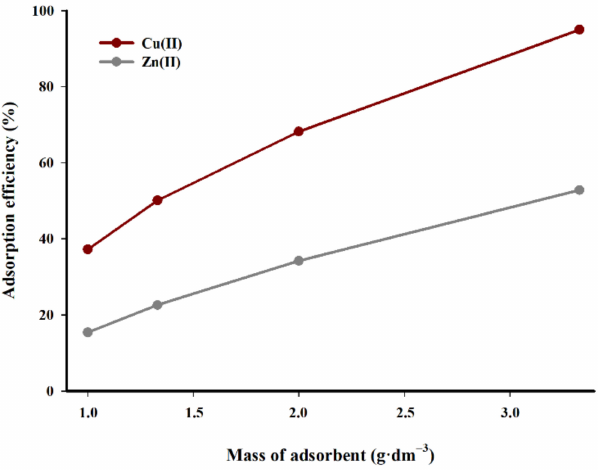
Figure 8. Effect of the adsorbent mass (g · dm − 3 ) on the adsorption efficiency (T = 298.15 K, t = 240 min, c = 100 mg · dm − 3 , pH =